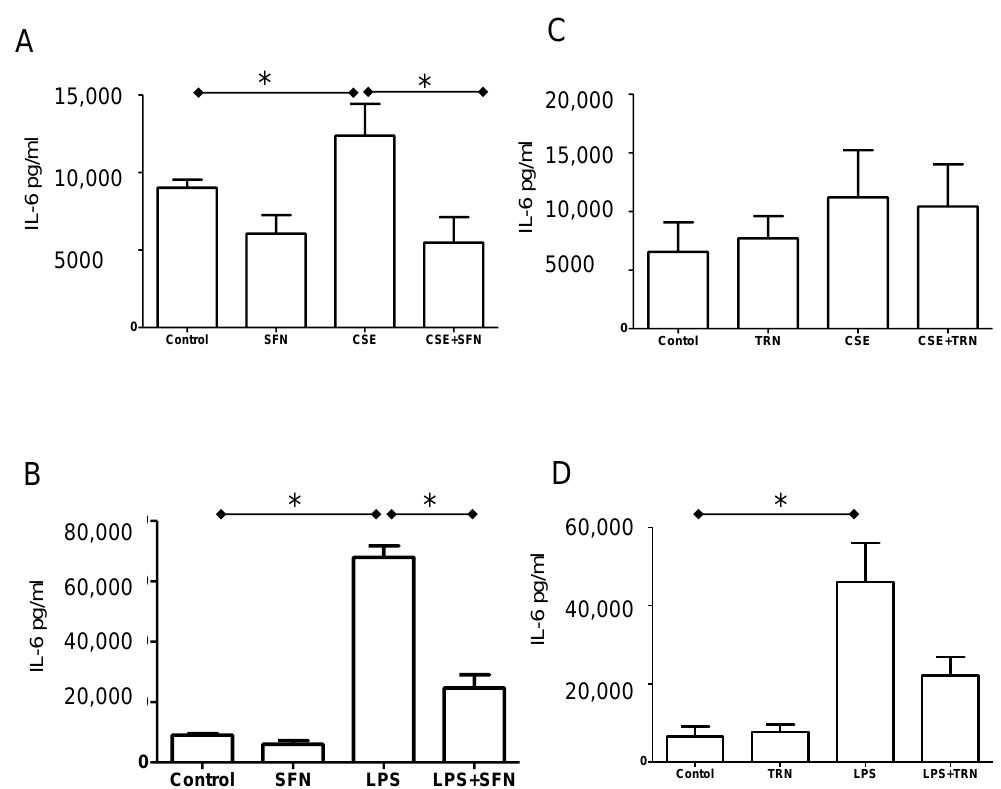
Figure 4. Interleukin (IL)-6 levels in culture supernatant from fetal membrane tissue homogenates determined by ELISA. * p < 0.05. ( A ): Fetal membranes treated with sulforaphane (SFN), cigarette smoke extract (CSE) and CSE + SFN. ( B ): Fetal membranes treated with SFN, lipopolysaccharide (LPS) and LPS + SFN. ( C ): Fetal membranes treated with trigonelline (TRN), CSE and CSE + TRN. ( D ). Fetal membranes treated with TRN, LPS and LPS +